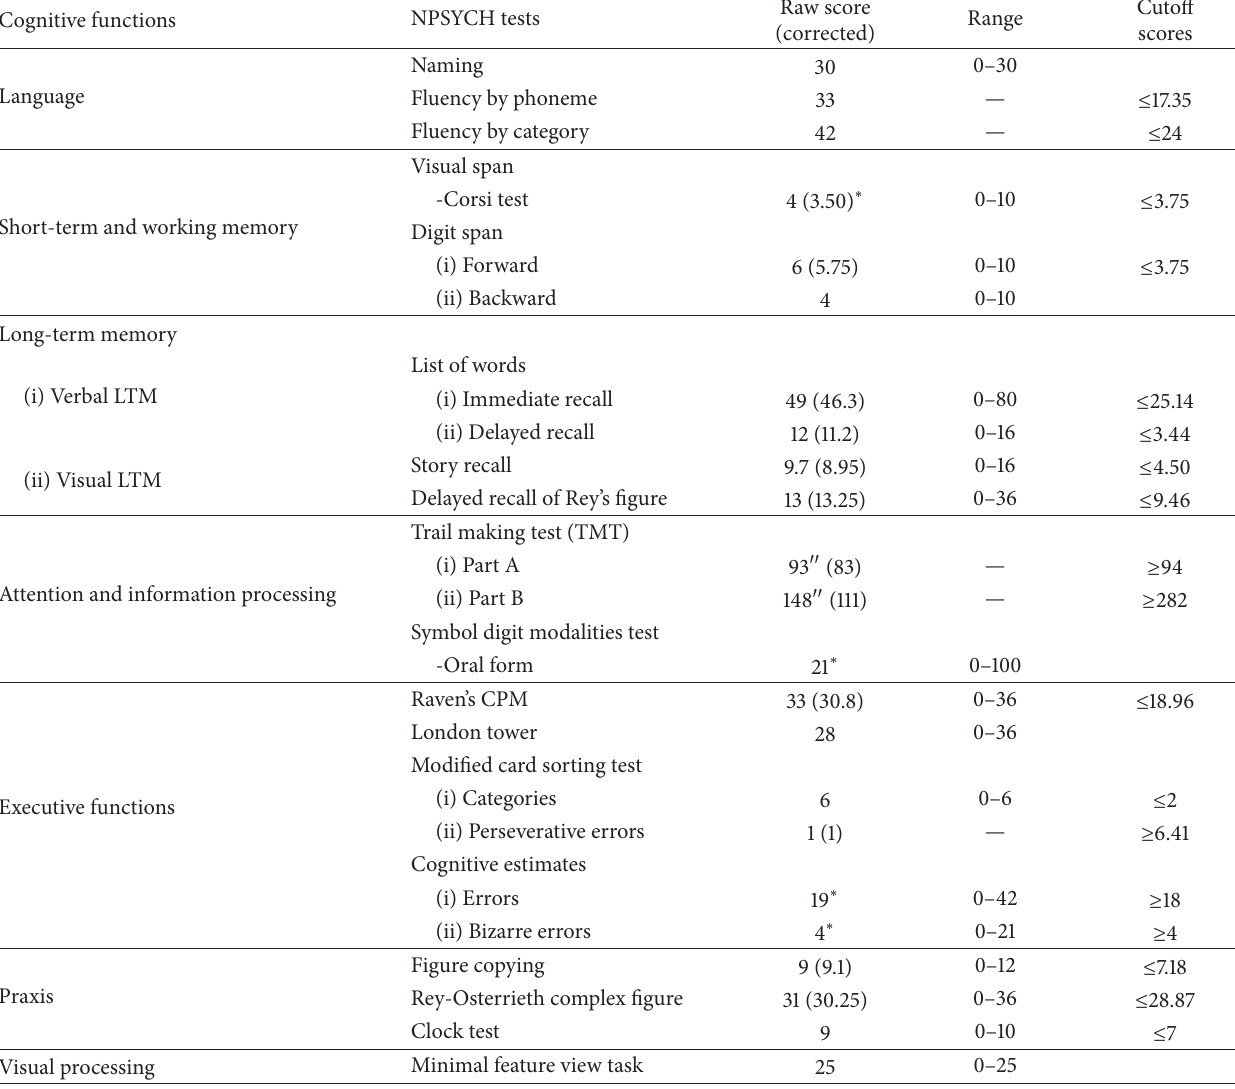
Table 1: DA performance on neuropsychological testing (the star indicates scores below